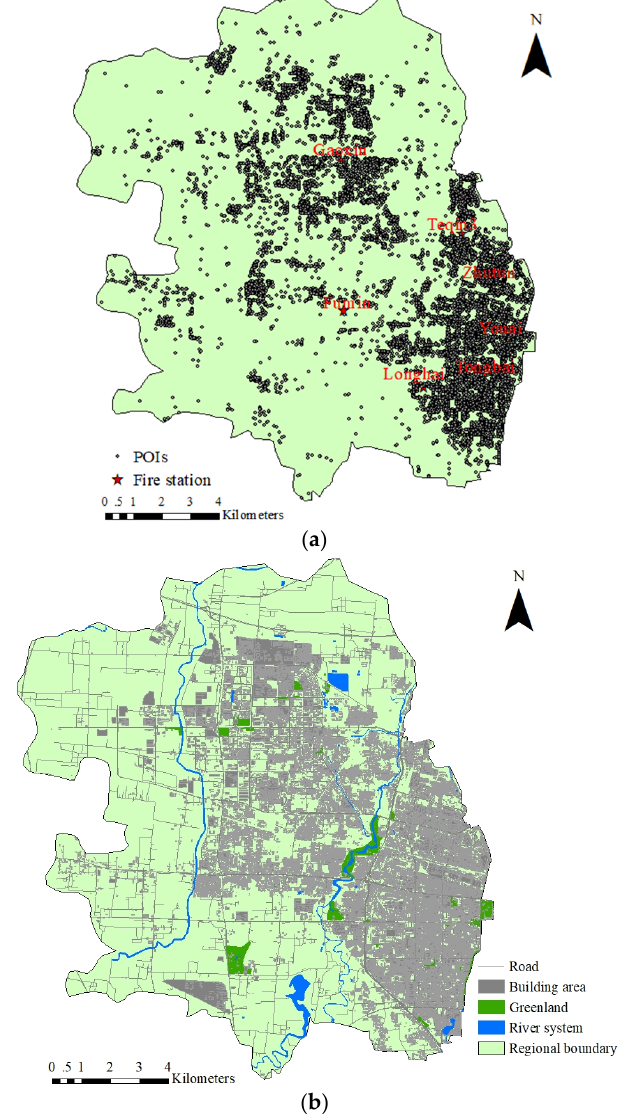
Figure 2. POIs, roads, and buildings distribution of Zhongyuan District. ( a ) POIs distribution. ( b ) roads and buildings distribution. Table 1. The number of POIs in various places.